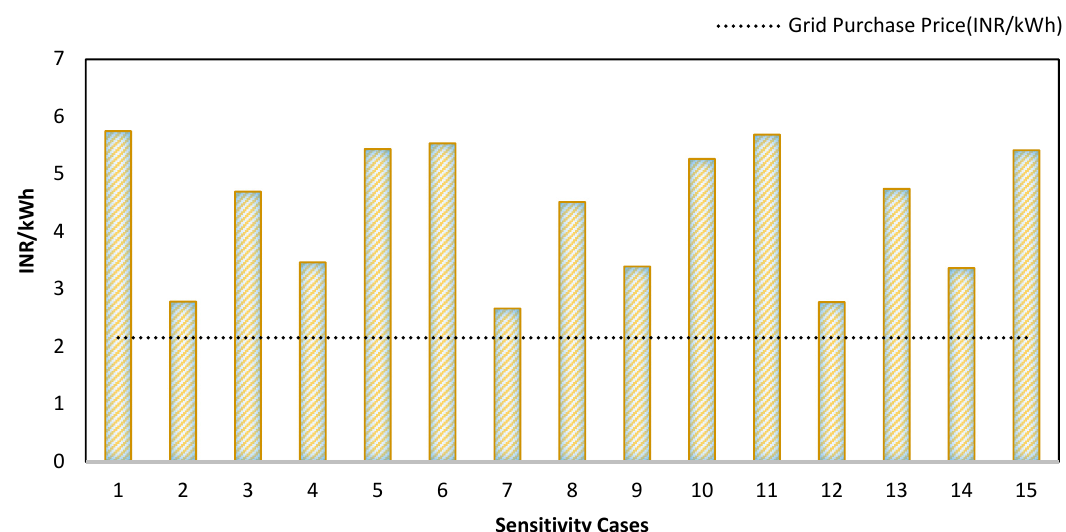
Figure 13. The LCOE from HRES and the grid electricity price